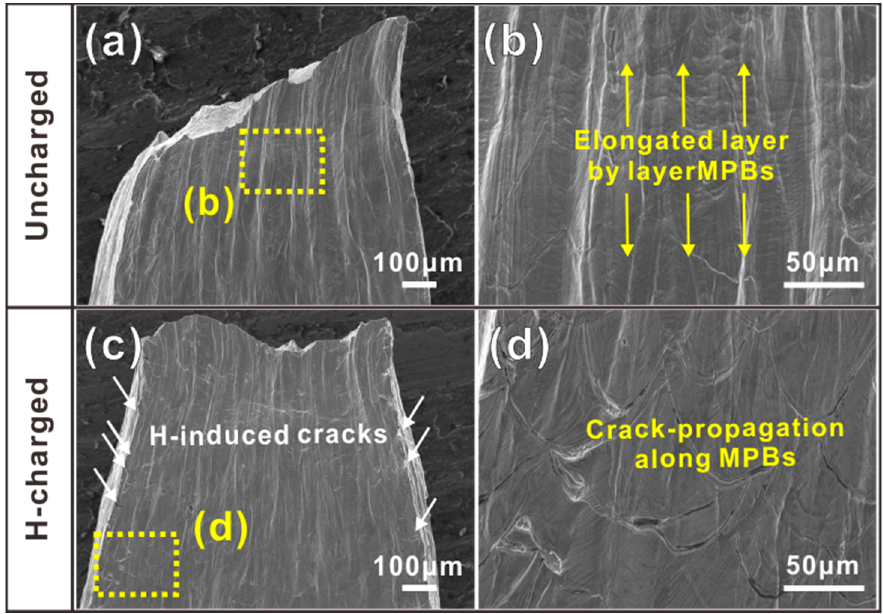
Figure 6. Tensile lateral surfaces of fractured samples of ( a , b ) uncharged sample and ( c , d ) H-charging sample.